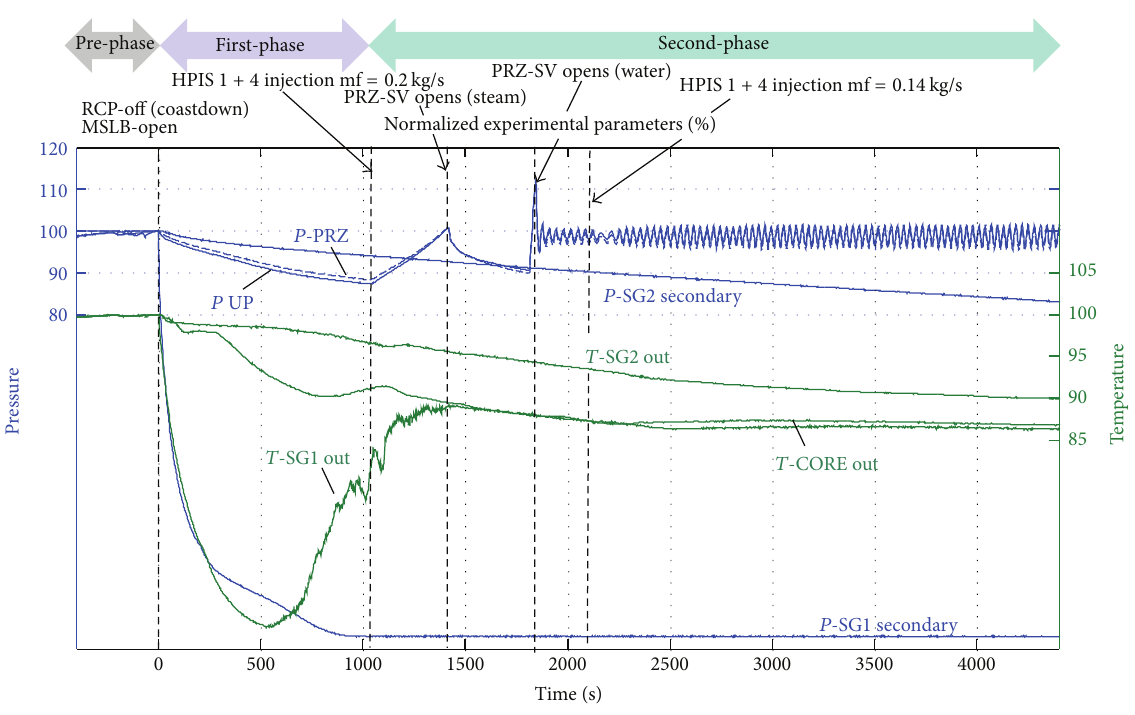
Figure 1: Main experimental parameter